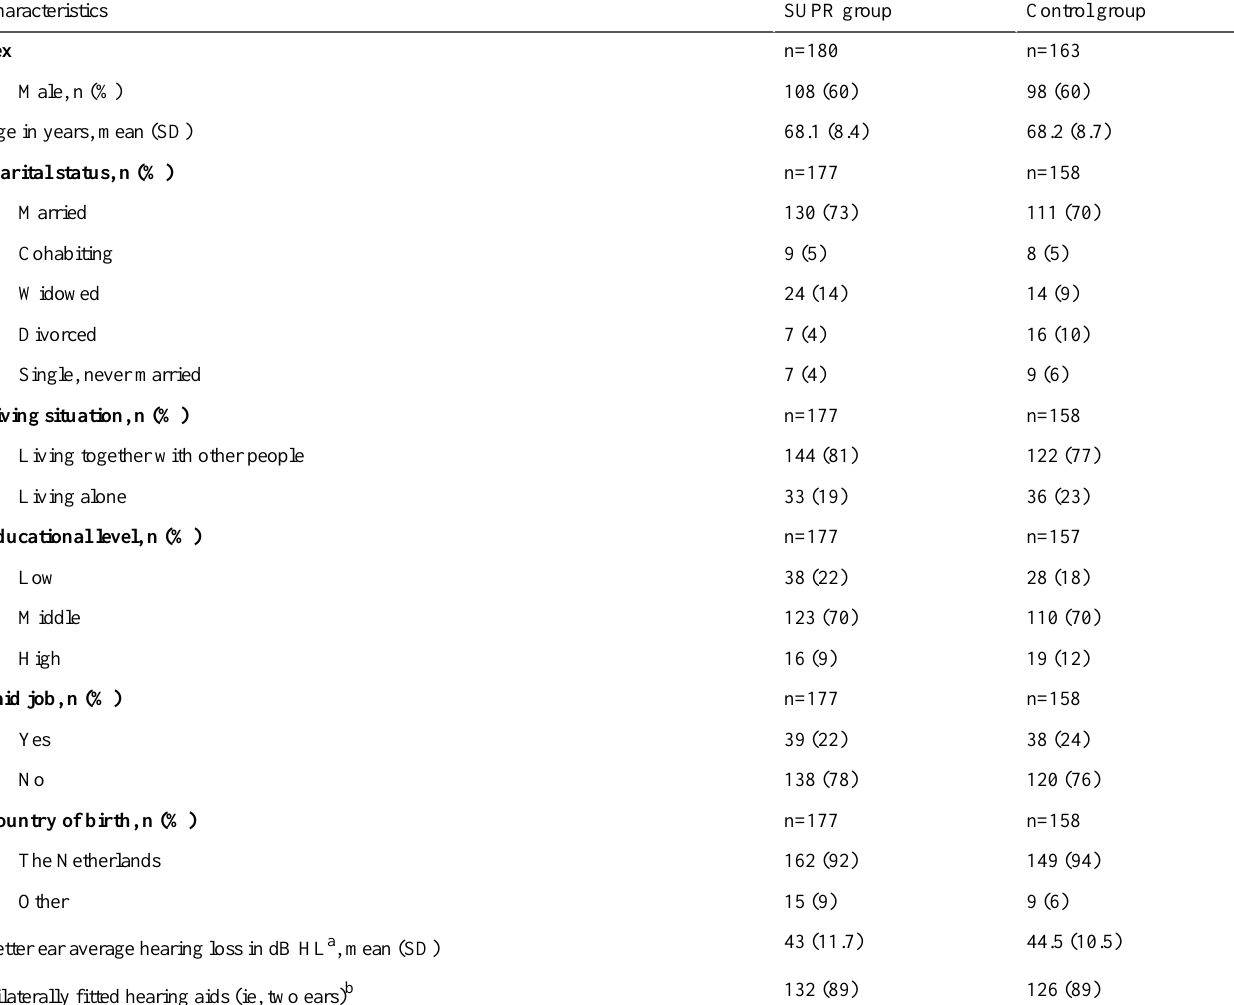
Table 2. Baseline